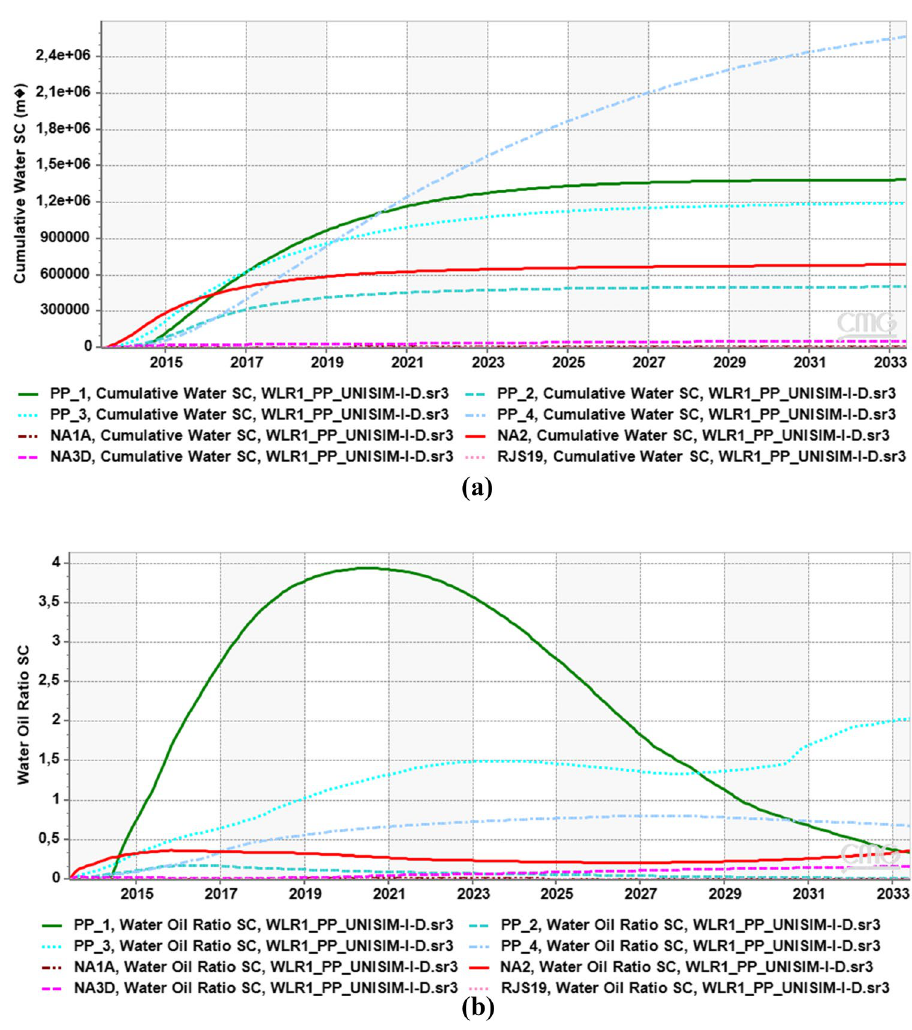
Fig. 9 CWP-SC ( a ) and WOR- SC ( b ) for UNISIM and PP